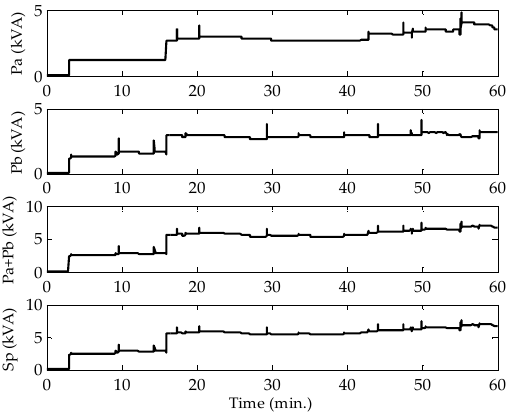
Figure 19. The secondary and primary side power for the transformer.